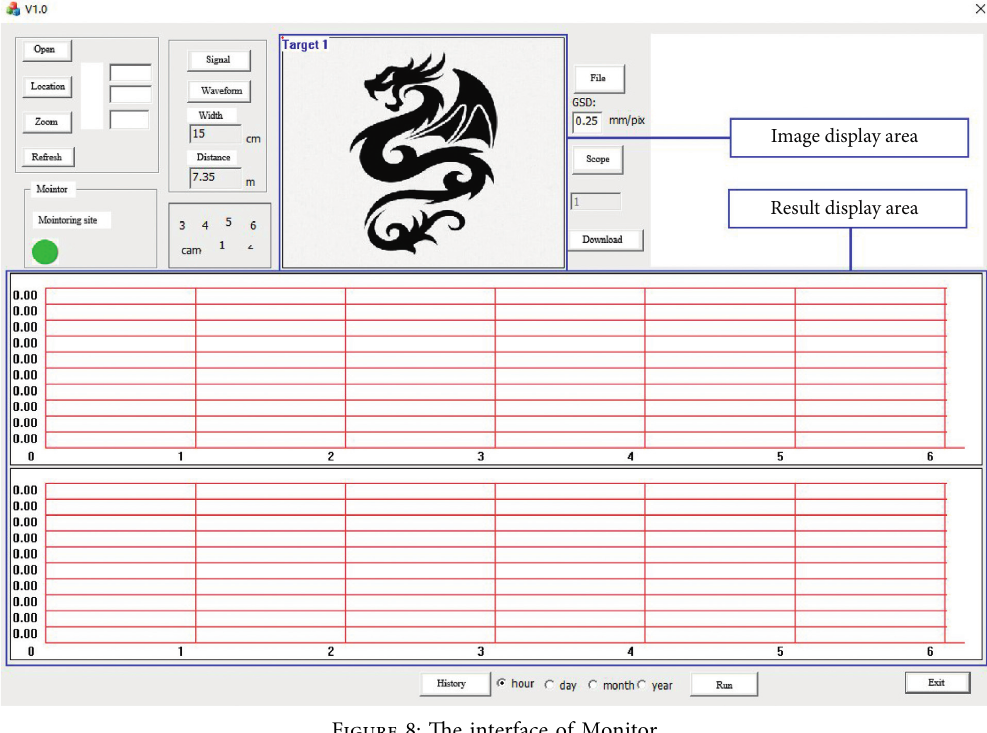
Figure 8: The interface of Monitor.